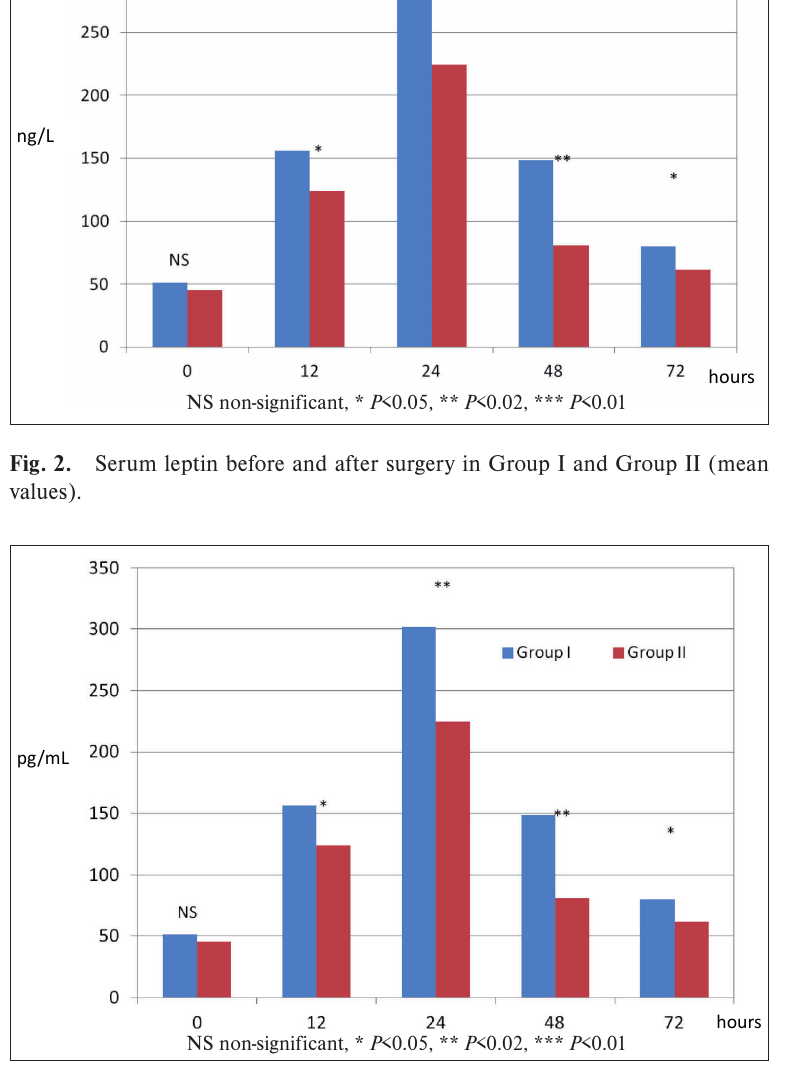
Fig. 3. Serum TNF-α before and after surgery in Group I and Group II (mean